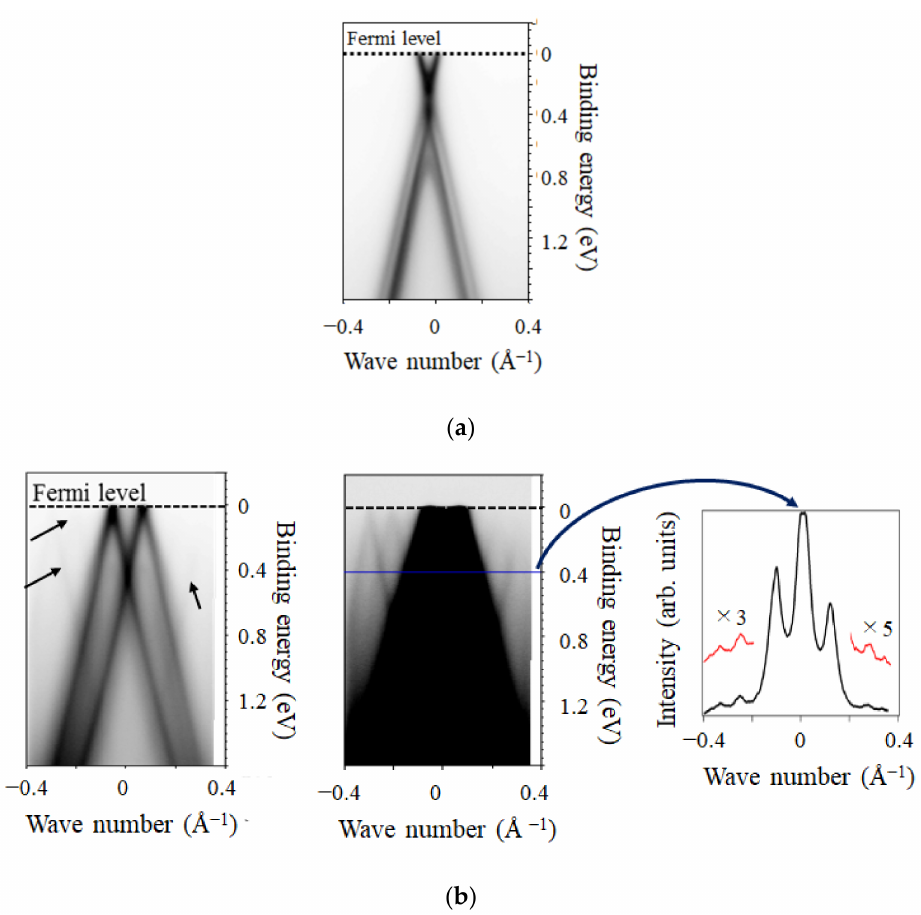
Figure 3. Angle-resolved photoelectron spectra images of few-layer graphene (FLG) on ( a ) the Si-face hybrid SiC and ( b ) the C-face hybrid SiC, respectively. In ( b ), the images with different contrasts and the line profile of the intensity at the binding energy of 0.4 eV for the sake of clarity of the faint